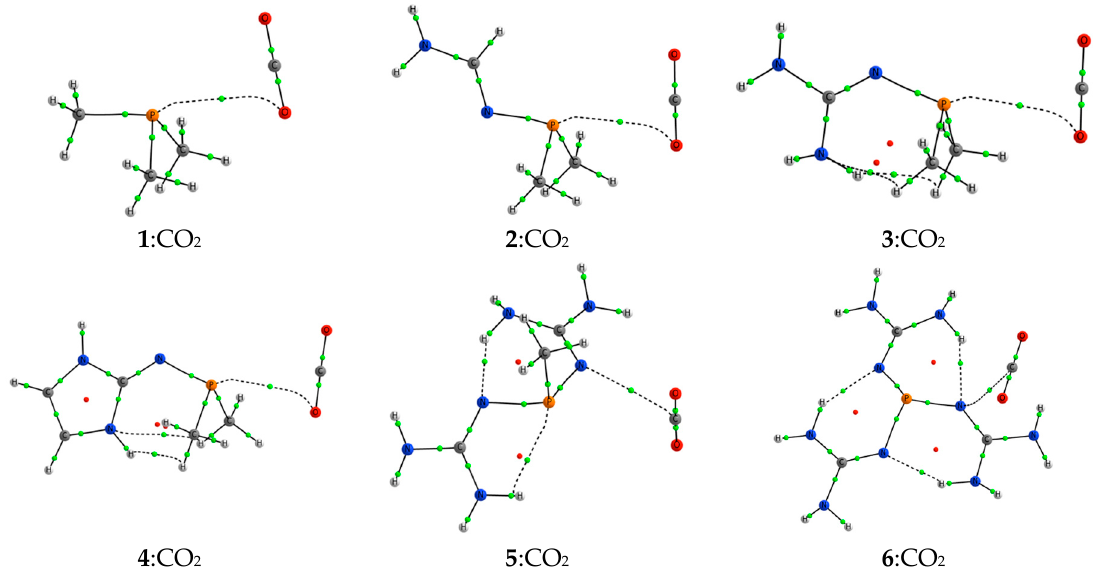
Figure 5. Molecular graphs for the 1 – 6 :CO 2 complexes. The small green and red spheres represent the position of the bond and ring critical points, respectively.